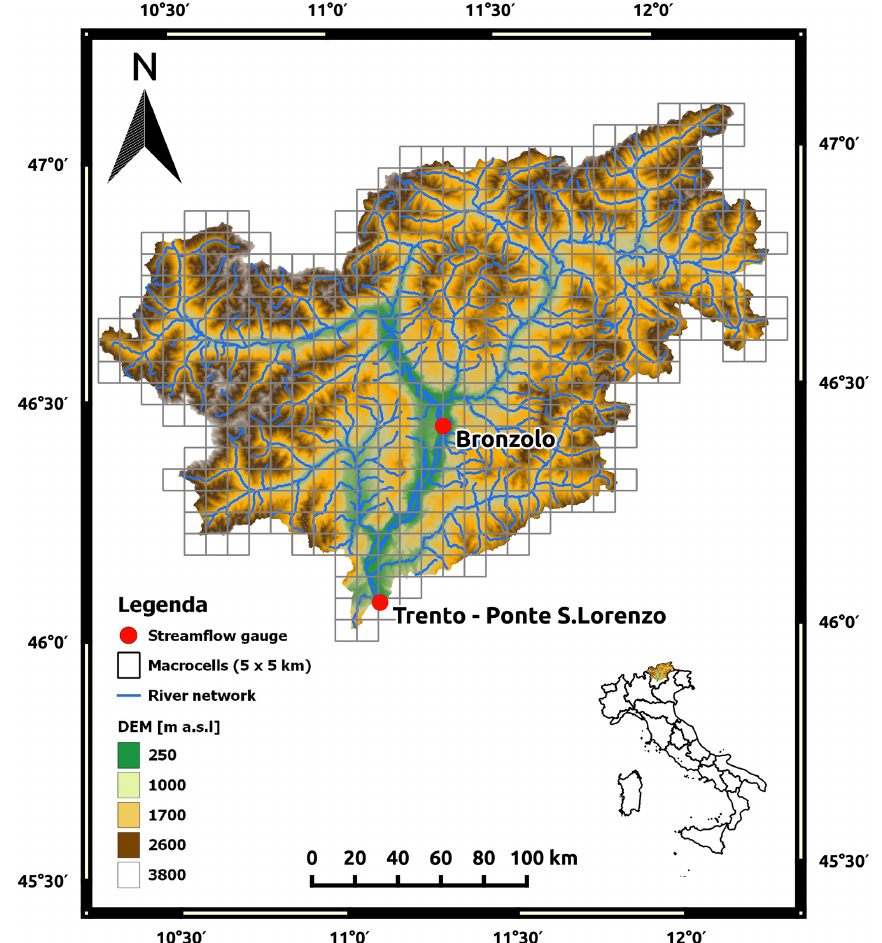
Figure 1. Map of the Adige River basin, with the computational grid cells (“macrocells”) superimposed on the digital elevation model (DEM) and the river network. The streamflow gauging stations used in the study are marked with red dots. The inset shows the location of the Adige River basin within the Italian